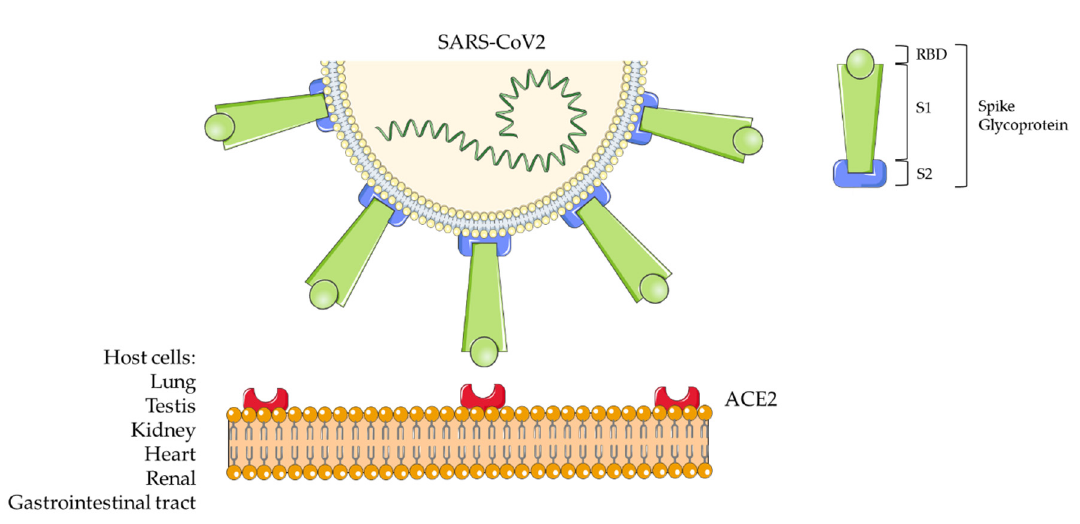
Figure 1. Severe Acute Respiratory Syndrome-Coronavirus 2 (SARS-CoV2) structure and host cell interaction.